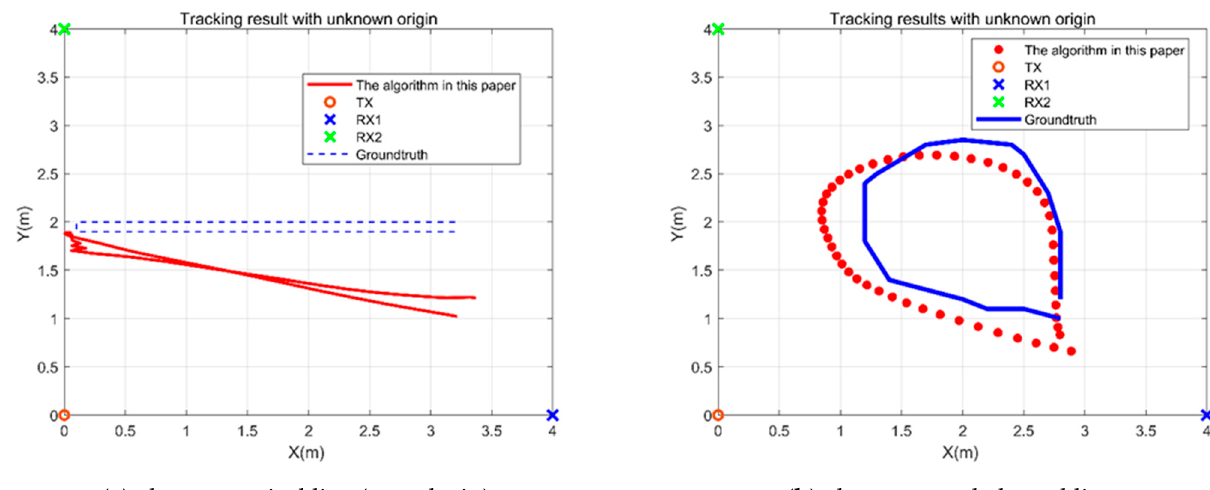
Figure 14. The trajectory prediction of a person walking in Environment 2.